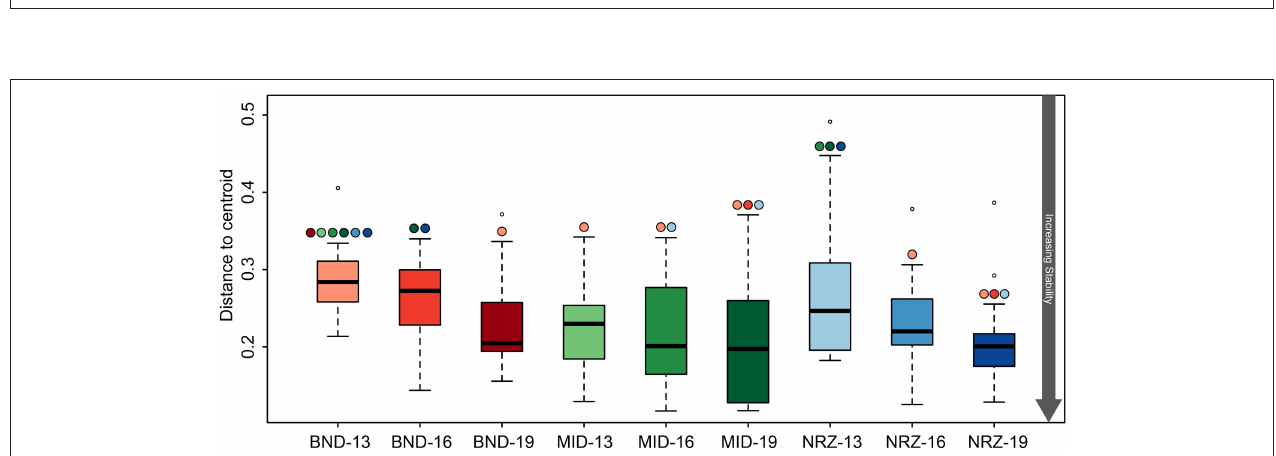
FIGURE 7 | Boxplots illustrating the test for homogeneity for the 16S rRNA gene microbial community data. Like the geochemical test for homogeneity ( Figure 3 ), a lower “distance to centroid” value indicates a more stable system while a larger value is less stable. The colored circles above the whiskers indicate where significant differences exist between the average values. For example BND-13 is significantly less than stable than MID-13.